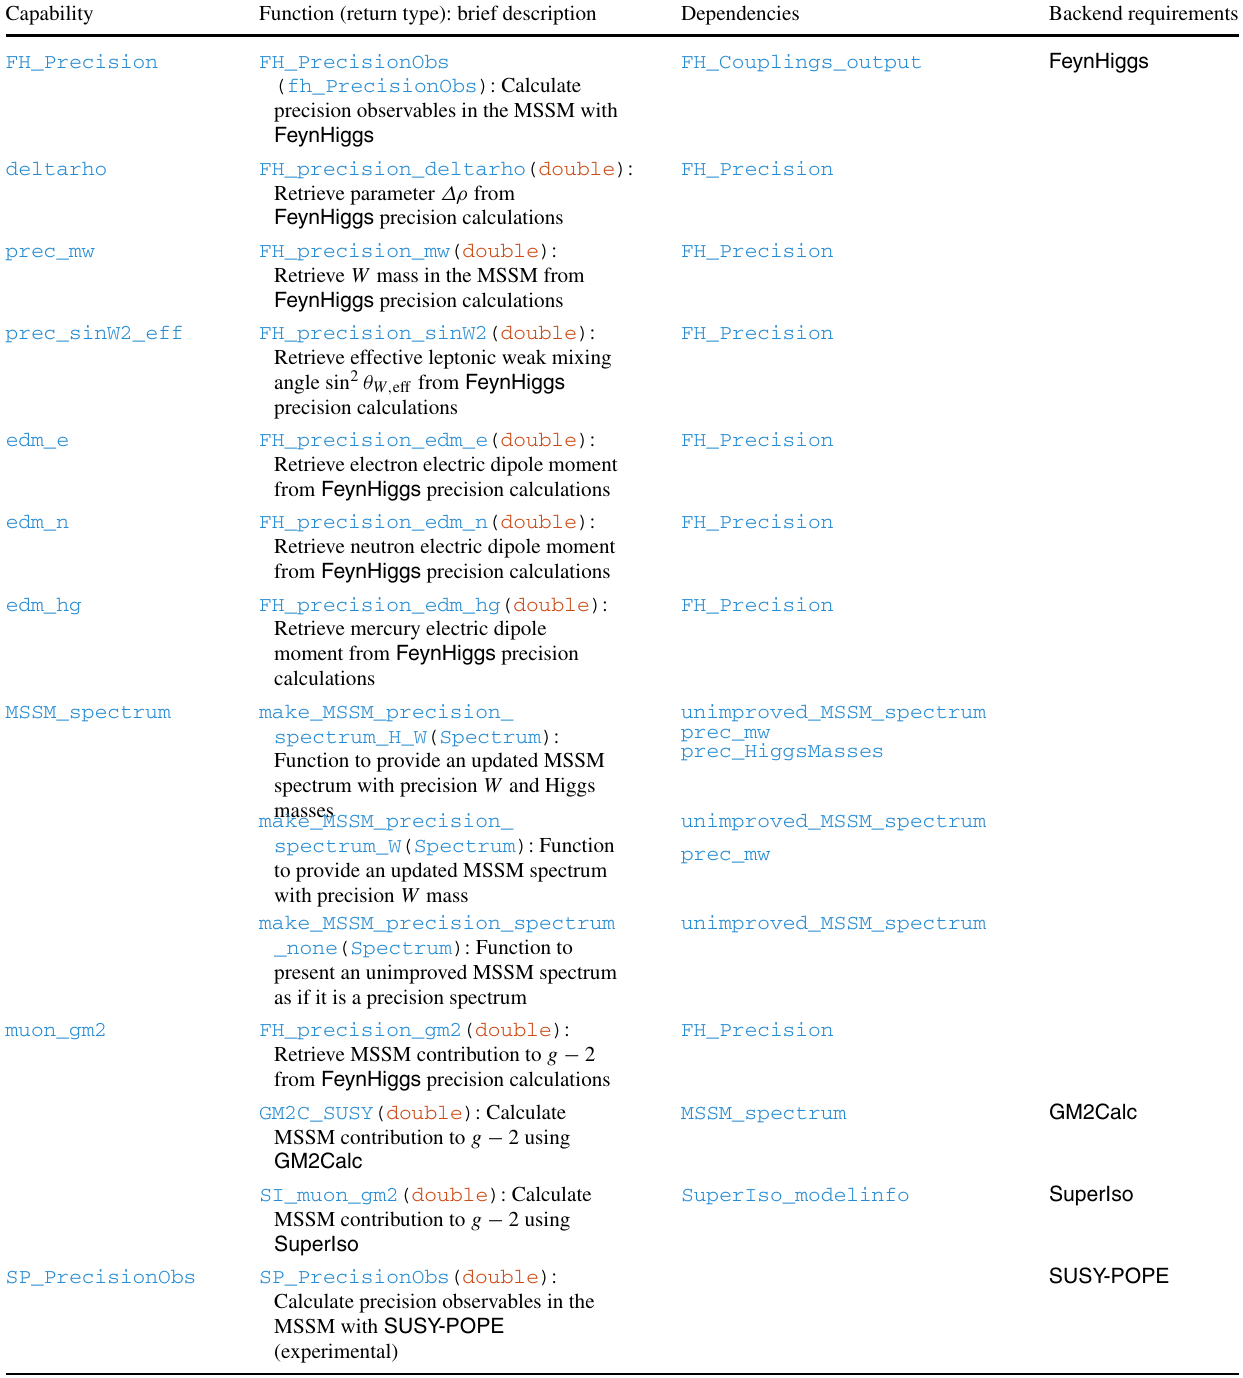
Table 10 PrecisionBit module function interfaces to external code packages for calculation of precision observables. These functions include calculations of backend-specific data-types for input to other